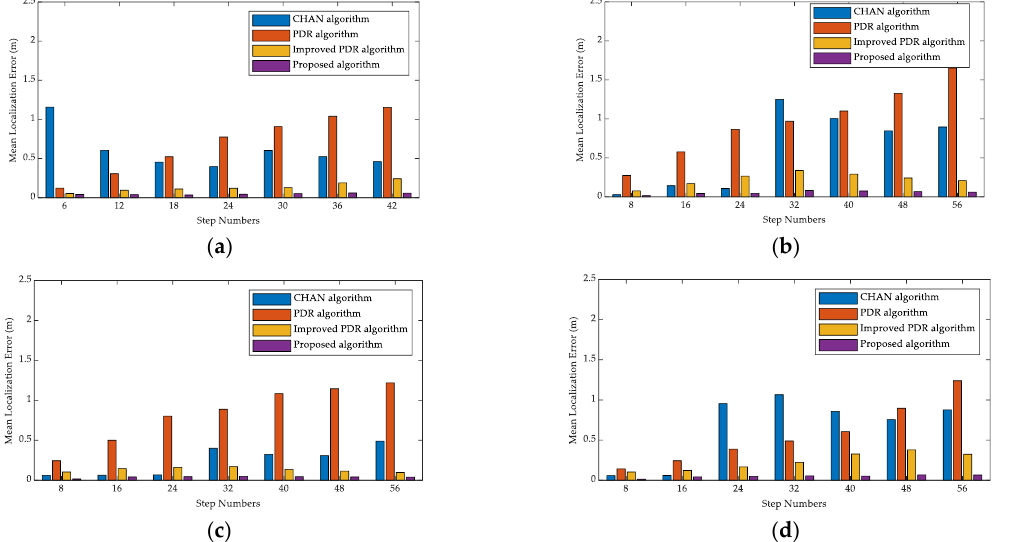
Figure 16. Mean localization errors among CHAN, PDR, improved PDR, and the proposed algorithm with different step counts. ( a ) Volunteer #2 with a VivoY85a cell phone (scene 1). ( b ) Volunteer #2 with a VivoY85a cell phone (scene 2). ( c ) Volunteer #1 with a VivoY85a cell phone (scene 2). ( d ) Volunteer #1 with an Honor60 cell phone (scene 2).